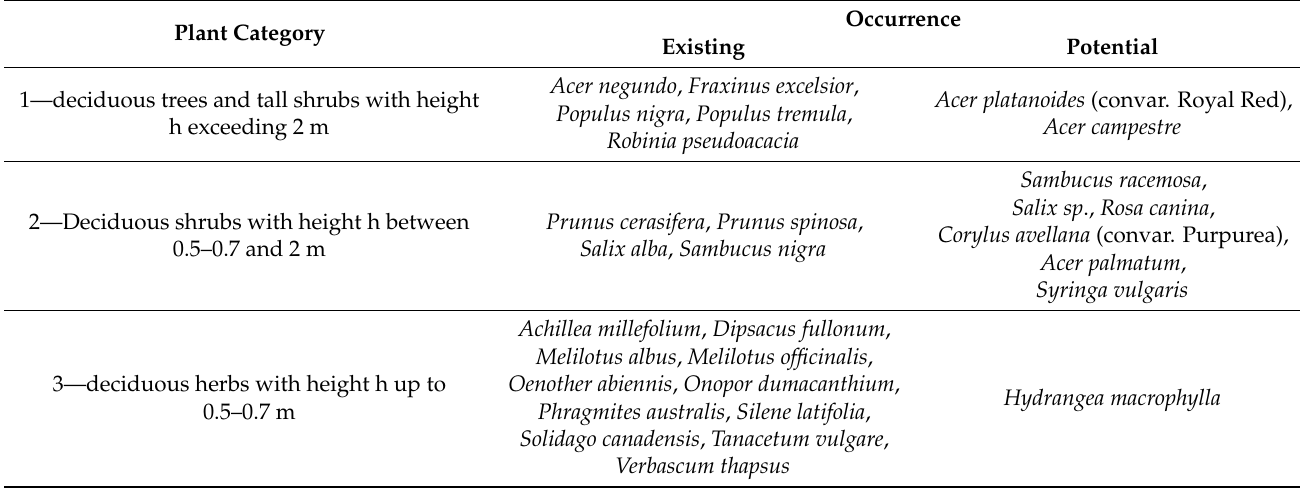
Table 4. Plant categories and species which may be used in landfill reclamation.